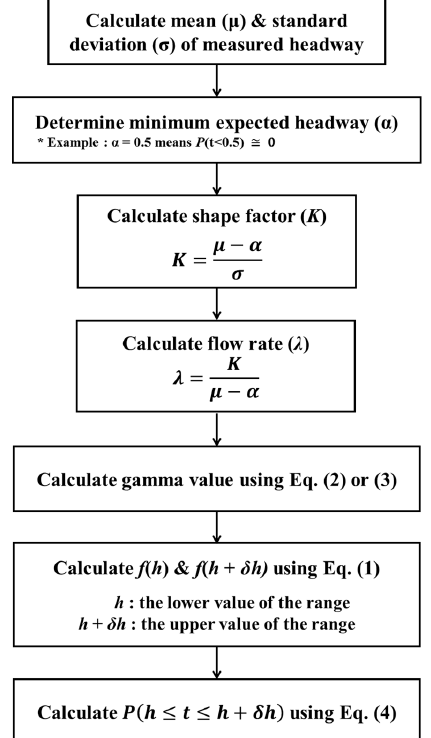
Figure 4. Procedure for applying a Pearson Type III distribution.